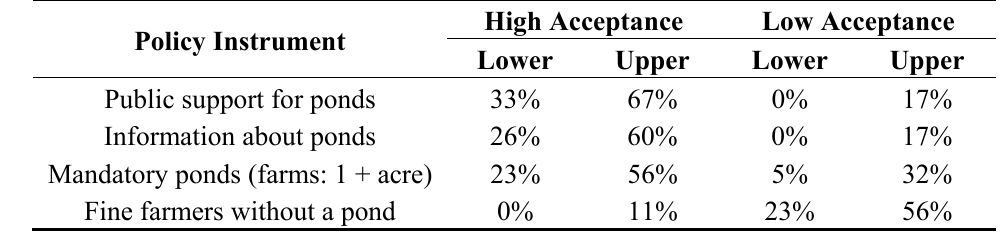
Table 5. One-sided 95% Clopper-Pearson confidence intervals for acceptance of